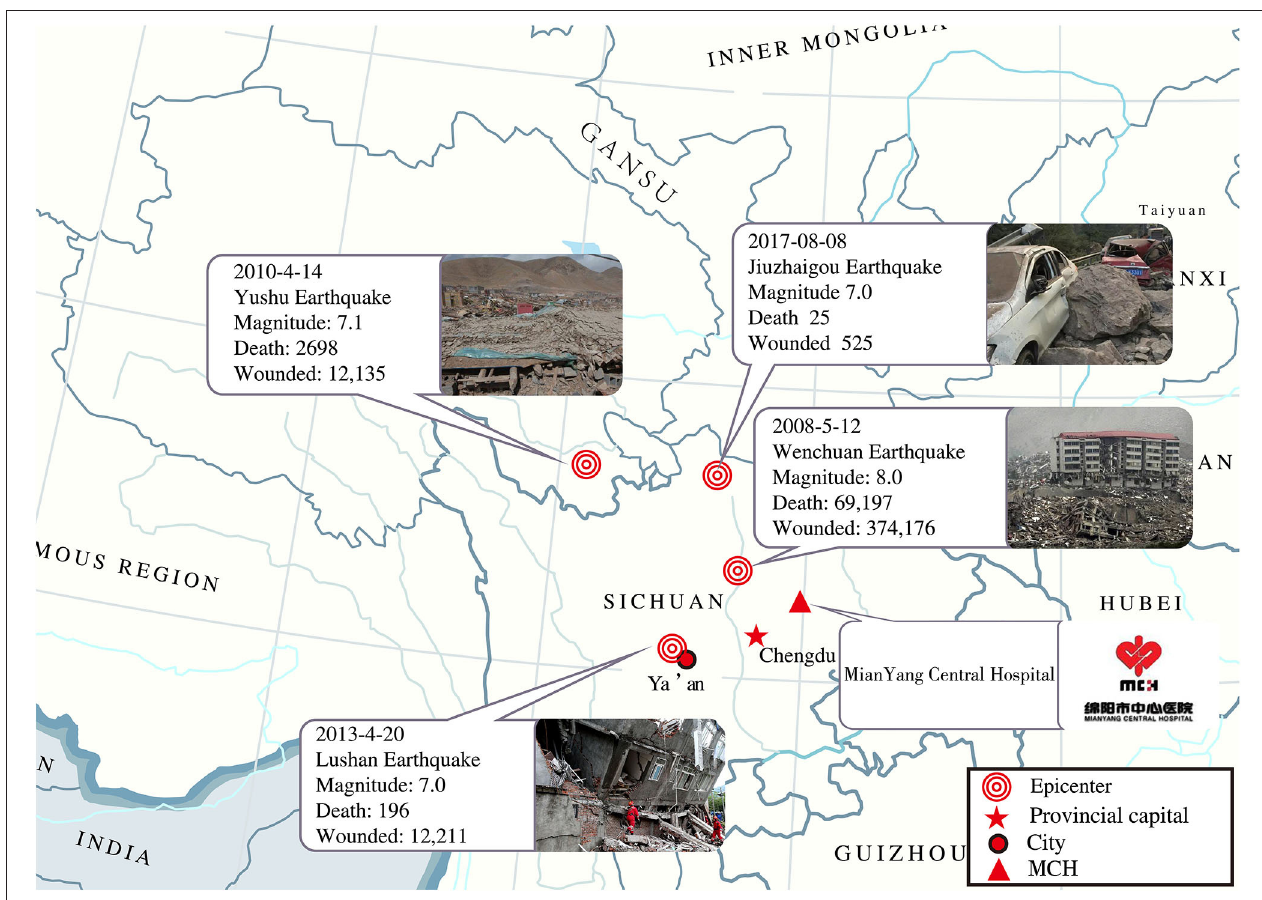
FIGURE 1 | Overview of four catastrophic earthquakes in the past 10 years in